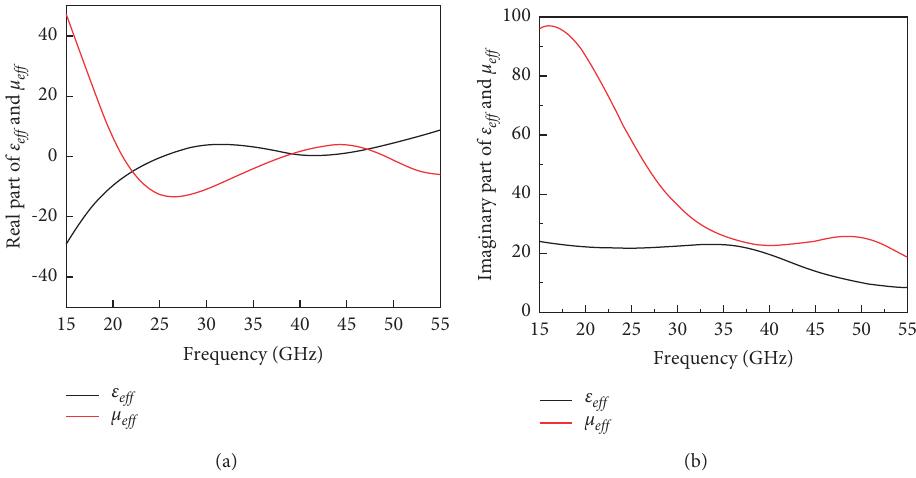
Figure 10: Equivalent constitutive parameters: (a) real part of ε